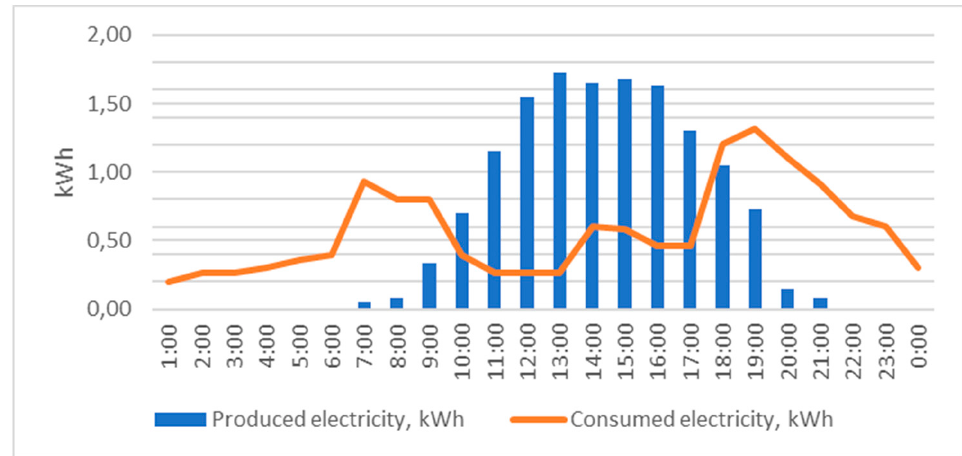
10 Figure 3. Average electricity power of a private house.